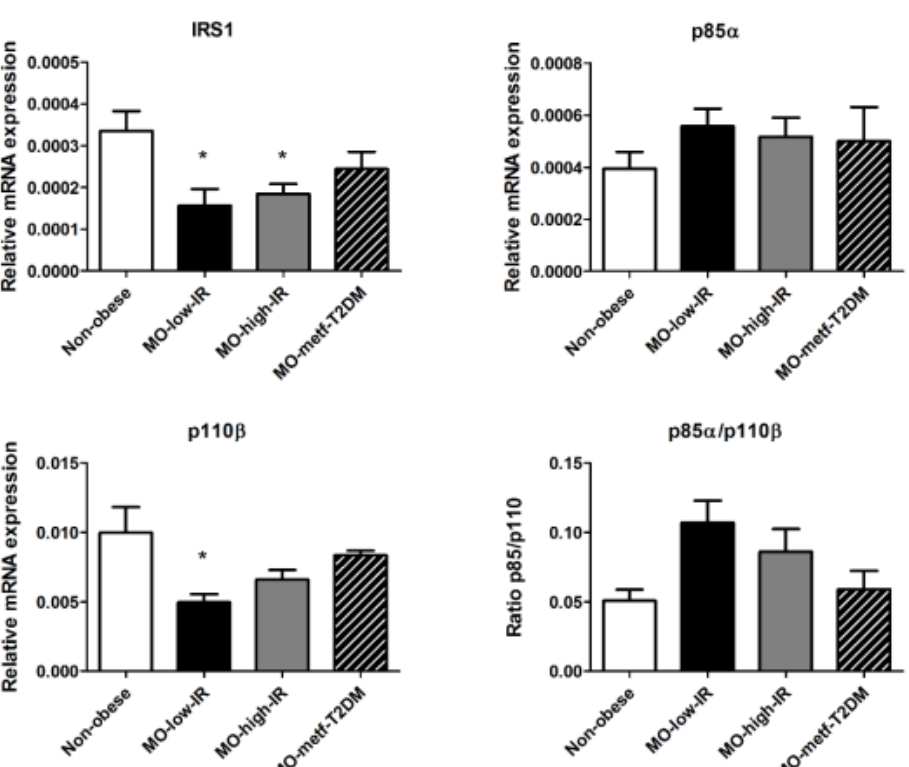
Figure 1. mRNA expression levels of IRS1, p85 α , p110 β and p85 α / p110 β ratio in VAT from non-obese patients and in patients with morbid obesity with low insulin resistance (MO-low-IR), with high insulin resistance (MO-high-IR), and with T2DM under treatment with metformin (MO-metf-T2DM). Gene expression was assessed using the 2 - ∆∆ Ct method. Results are represented as mean ± SEM. * p < 0.05 with regard to non-obese